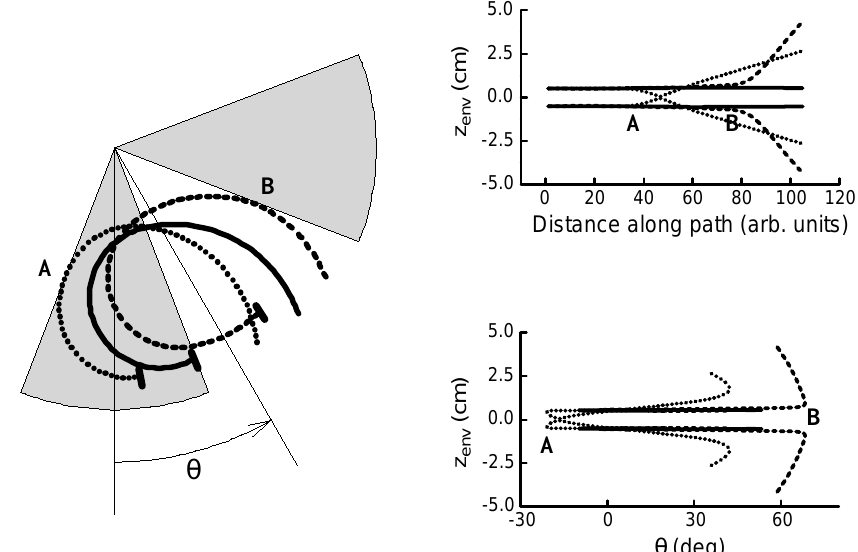
FIG. 4. Influence of the sector edge magnetic field gradient on the beam envelope. The left-hand plot shows three trajectories of test ions with K (cid:1) 2.42 . These are the central ions for test beams whose radial (horizontal) and axial (vertical) emittances at the foil position are taken to be ´ h (cid:1) 2 mm 6 mrad p (cid:1) 12 p mm mrad and ´ z (cid:1) 5 mm 1 mrad p (cid:1) 5 p mm mrad, respectively. The energy spread of the beam is assumed to be 6 1% . The two graphs on the right show the axial beam envelope along the beam path (upper graph) and with respect to the azimuthal position (lower graph). If the beam does not pass close to the sector edge its envelope does not suffer any visible changes, as represented by the solid line. Sector edge B causes defocusing in the axial direction of beam depicted by a dashed line. The beam shown by a dotted line is axially focused by the sector edge A and further over focused along the